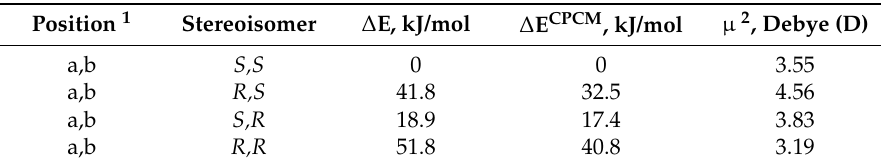
Table 3. The relative stability and dipole moments of the four stereoisomers of the prasugrel metabolite